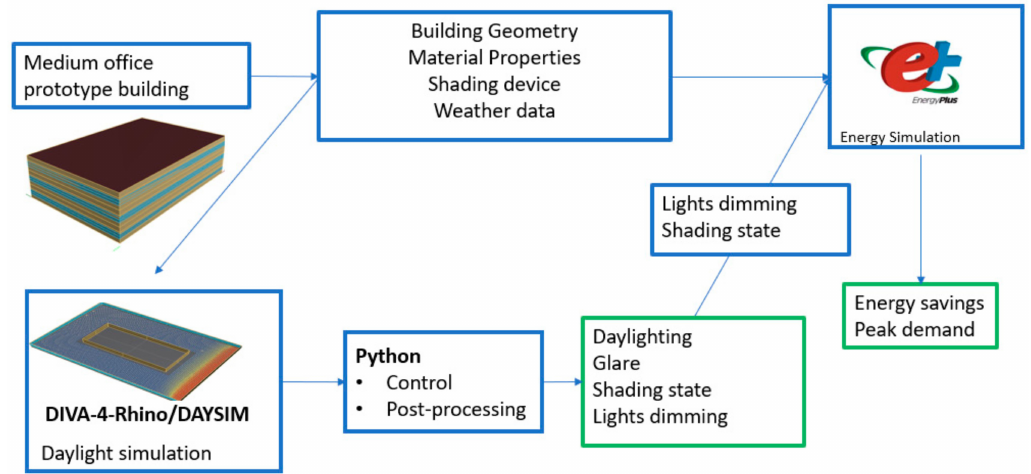
Figure 1. Overall framework used for integrated energy and daylighting simulations.